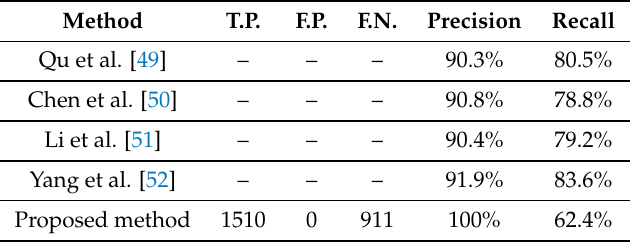
Table 2. The comparison of precision and recall of front vehicle detection for different algorithms. T.P.: true positive, F.P.: false positive, F.N.: false negative. Some previous works do not provide the numbers of true positives, false positives, and false